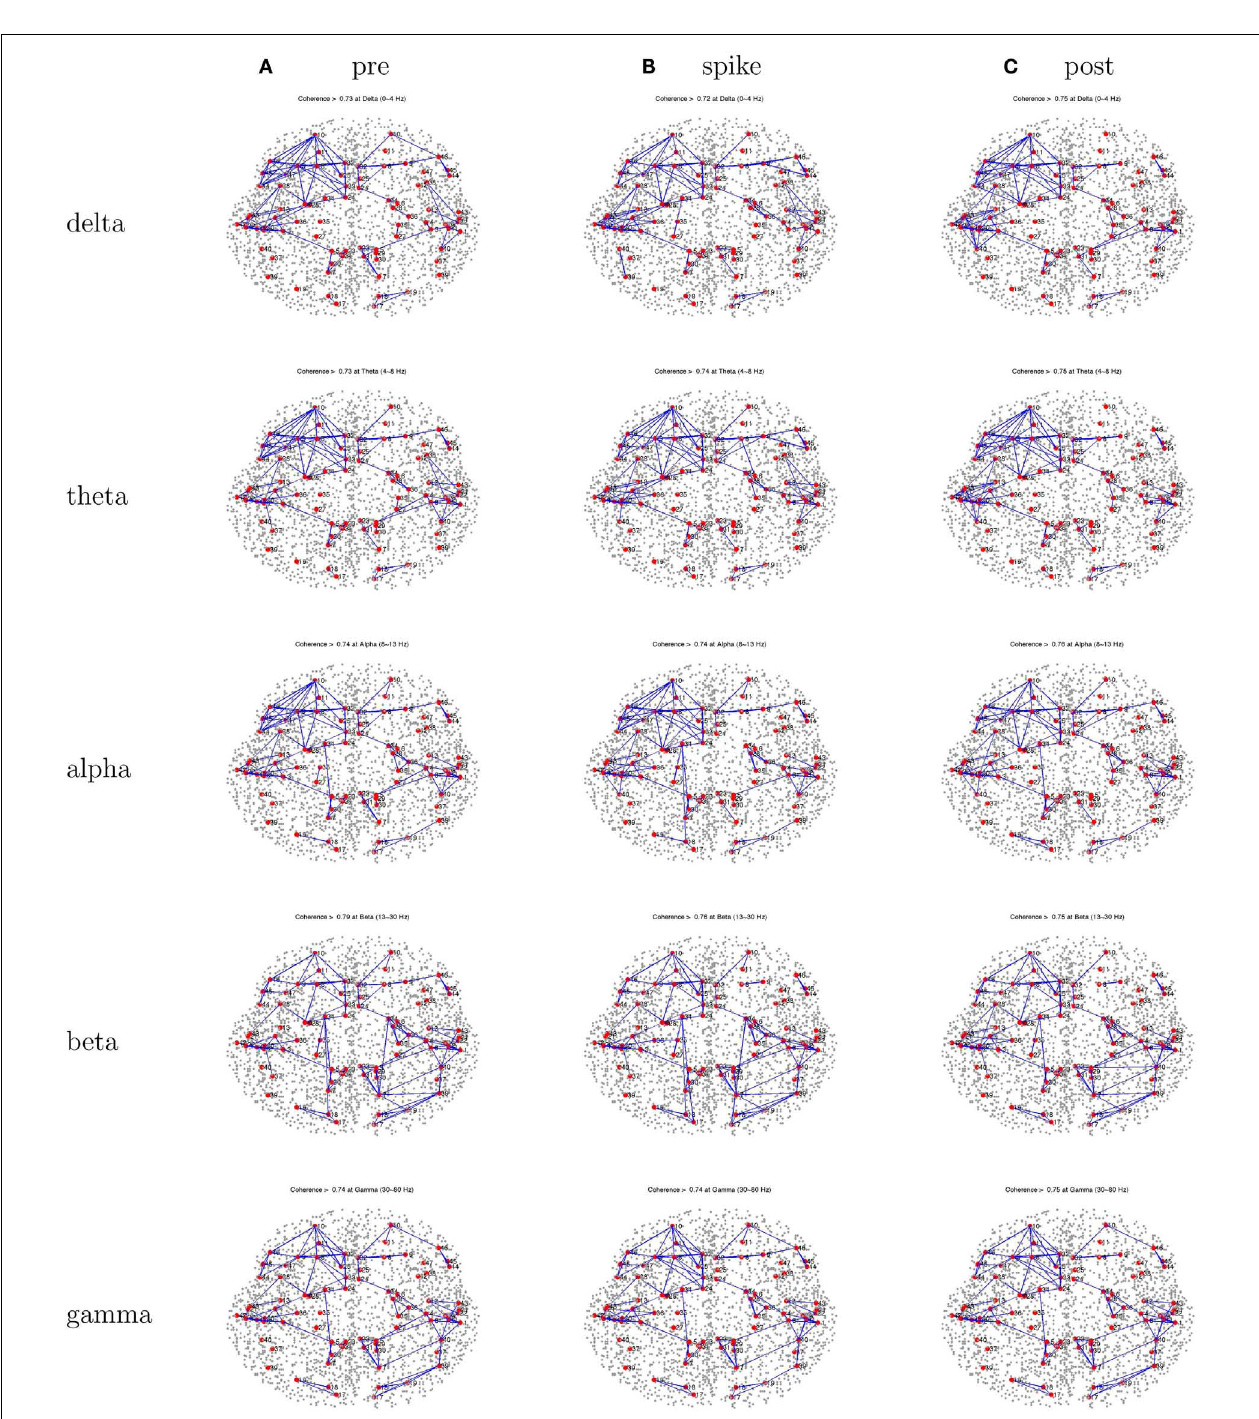
FIGURE 6 | Patient 2’s dEEG cortical source coherence peaks (highest 100 of ∼ 6400) for pre-spike (A), spike (B), and post-spike (C) intervals of the five frequency bands.